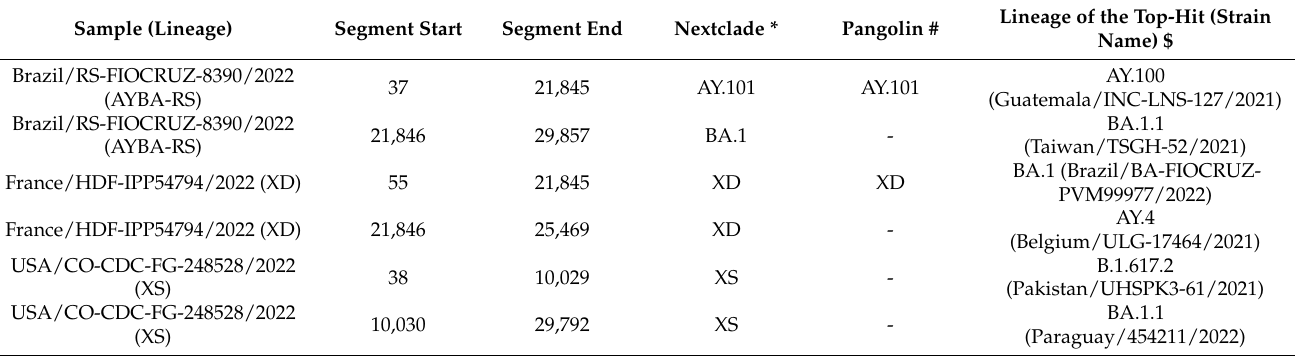
Table A2. Lineage identification of the segments of the earliest Deltacron sequences.